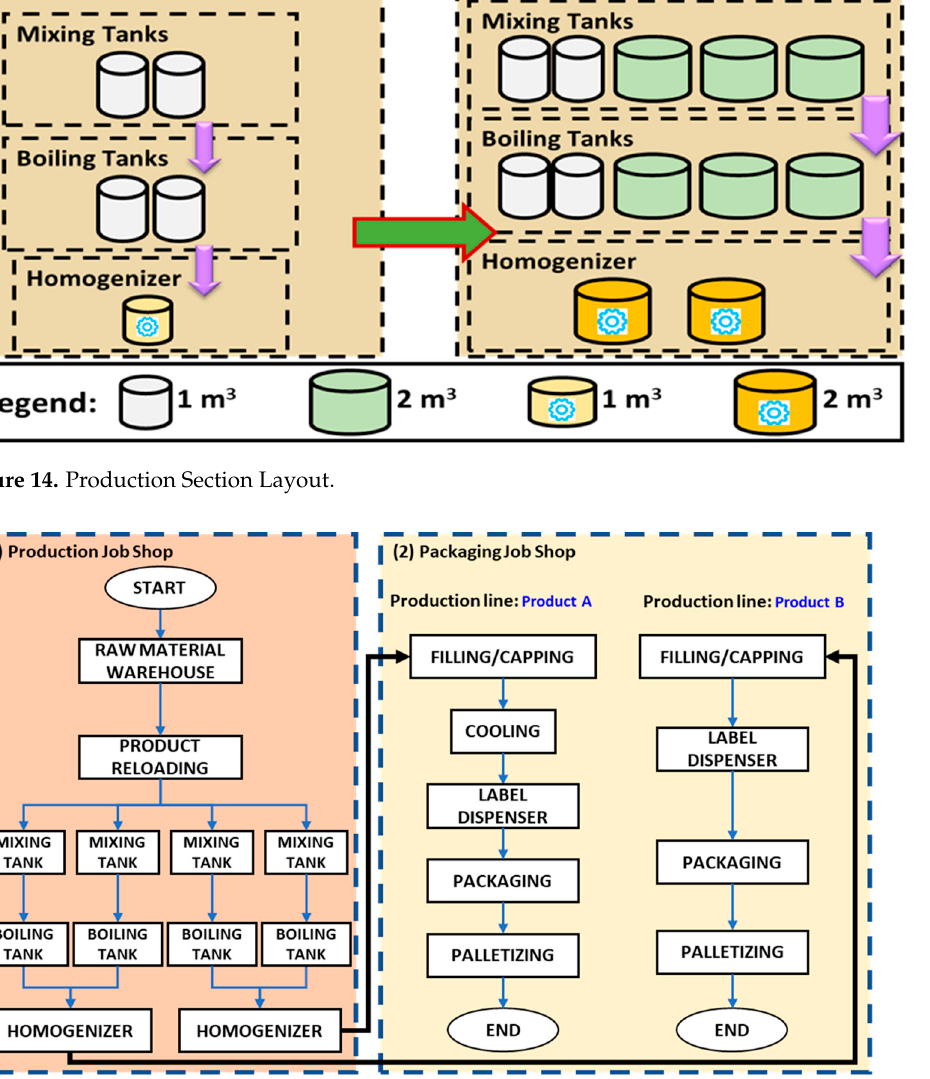
Table 15. Results of Digital Model—After the Implementation of Proposed Infrastructure.